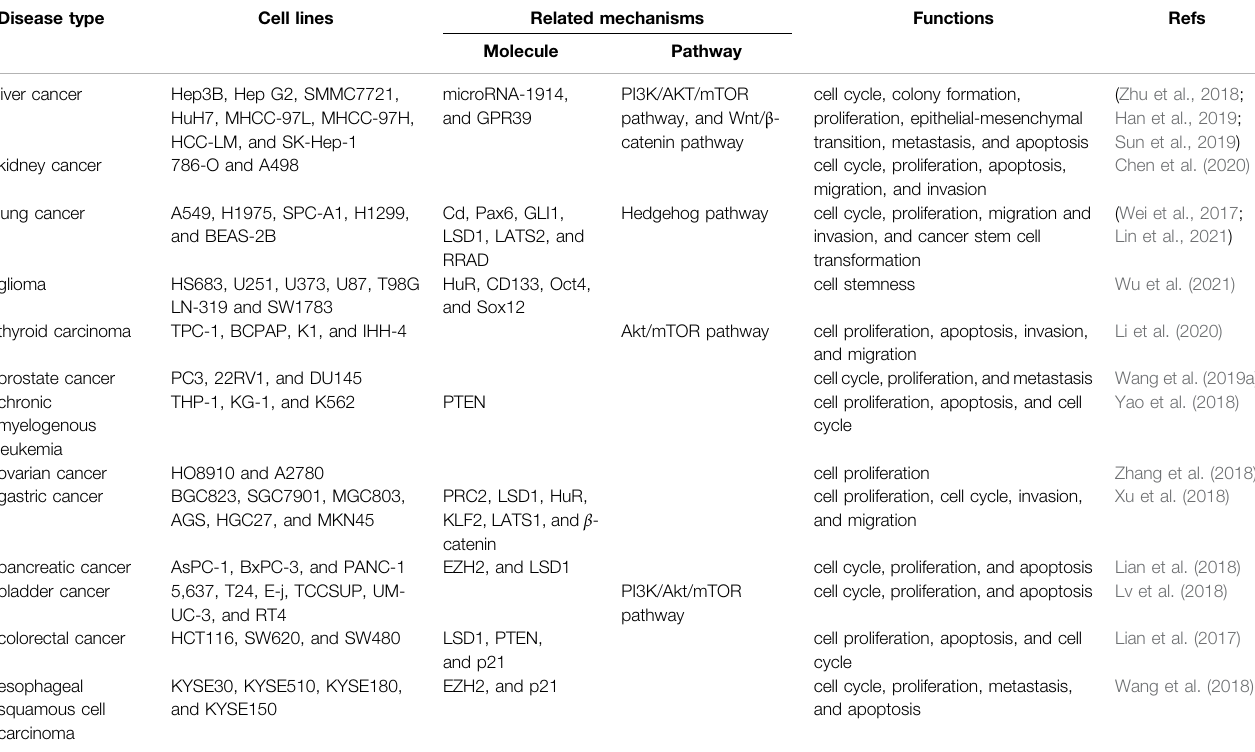
TABLE 2 | Functions and mechanisms of DUXAP10 in